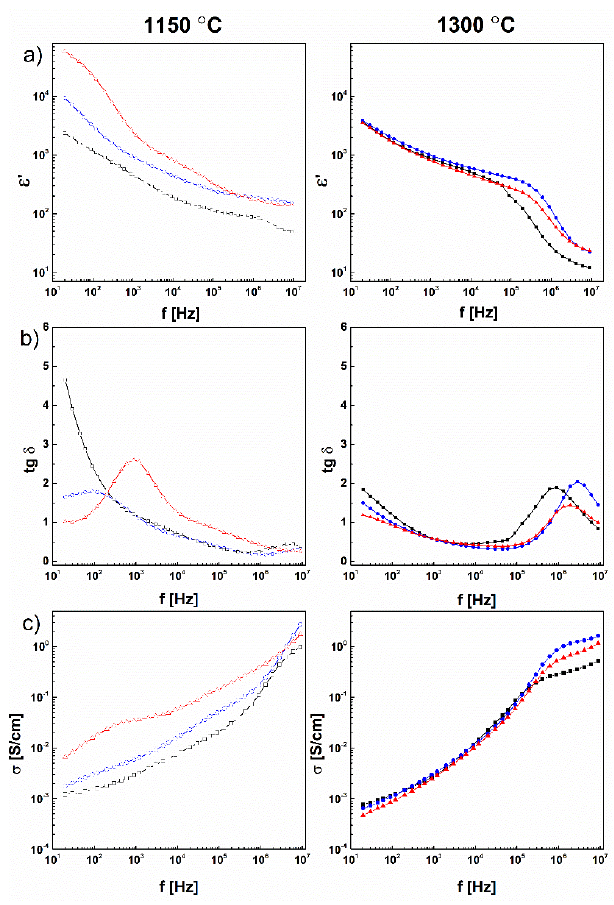
Figure 6. ( a ) Relative dielectric constant and ( b ) tangent loss as a function of frequency with ( c ) AC ( c ) AC conductivity for sintered materials. (BaTiO 3 /NiFe 2 O 4 —black, BaTiO 3 /ZnFe 2 O 4 —blue, and conductivity for sintered materials. (BaTiO 3 /NiFe 2 O 4 — black, BaTiO 3 /ZnFe 2 O 4 — blue, and BaTiO 3 /Ni 0.5 Zn 0.5 Fe 2 O 4 — red BaTiO 3 /Ni 0.5 Zn 0.5 Fe 2 O 4